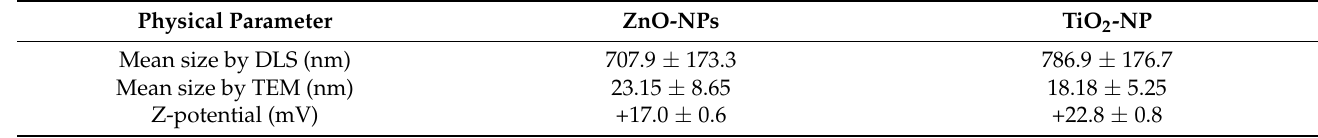
Figure 1. Physicochemical properties of nanoparticles (NPs). Histograms with the distribution of the sizes calculated by dynamic light scattering (DLS) ( A , B ) and transmission electron microscopy (TEM) ( C , D ). Pictures of both NPs for TEM ( E , F ). Table 1. Physicochemical properties of the TiO 2 - and ZnO-NPs (nanoparticles). Figure 1 shows the histograms with the distribution of the sizes determined by both dynamic light scattering (DLS) and transmission electron microscopy (TEM). Supplementary Materials Figure S1 shows the three Z-potential determinations run per each nanomaterial